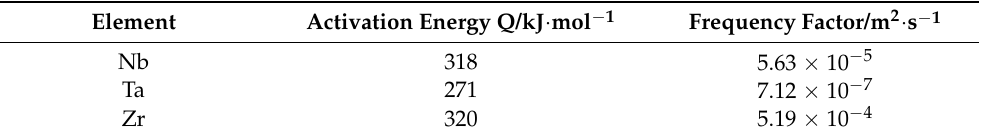
Figure 4. Arrhenius-plot of the average interdiffusion coefficients D of Nb, Ta and Zr determined in this work, compared with literature data from Herzig et al. (reproduced from Ref. [15]), in a temperature range of 1200 – 1300 °C. Table 3. Activation energy Q and frequency factor D 0 of the alloying elements Niobium, Tantalum and Zirconium in γ